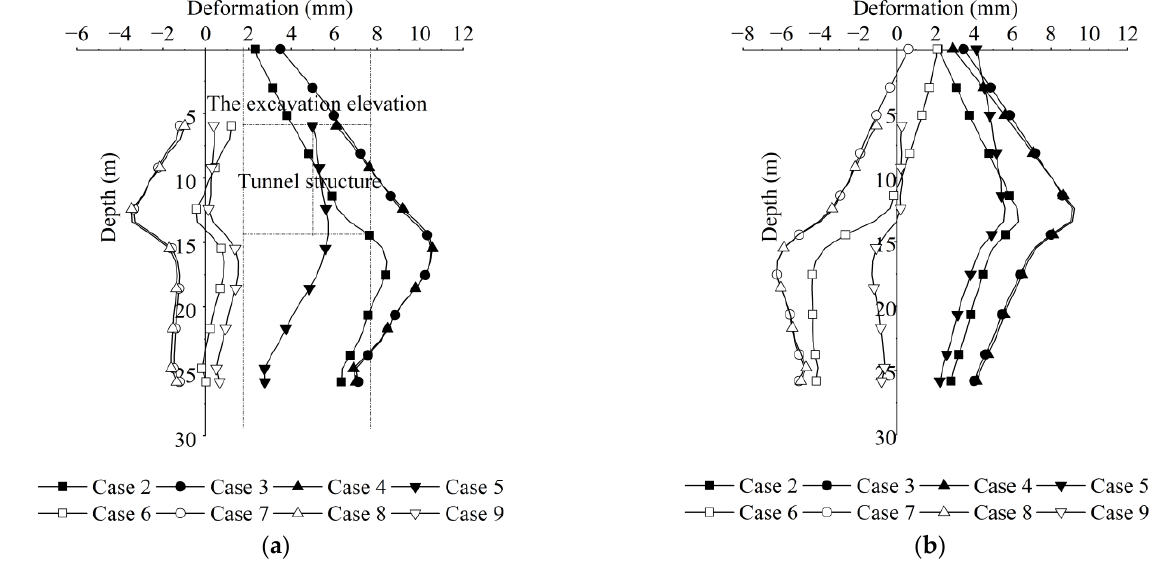
Figure 7. Lateral deformation of supporting pile by asymmetric construction method: ( a ) southern pile and ( b ) northern pile (unit: mm).